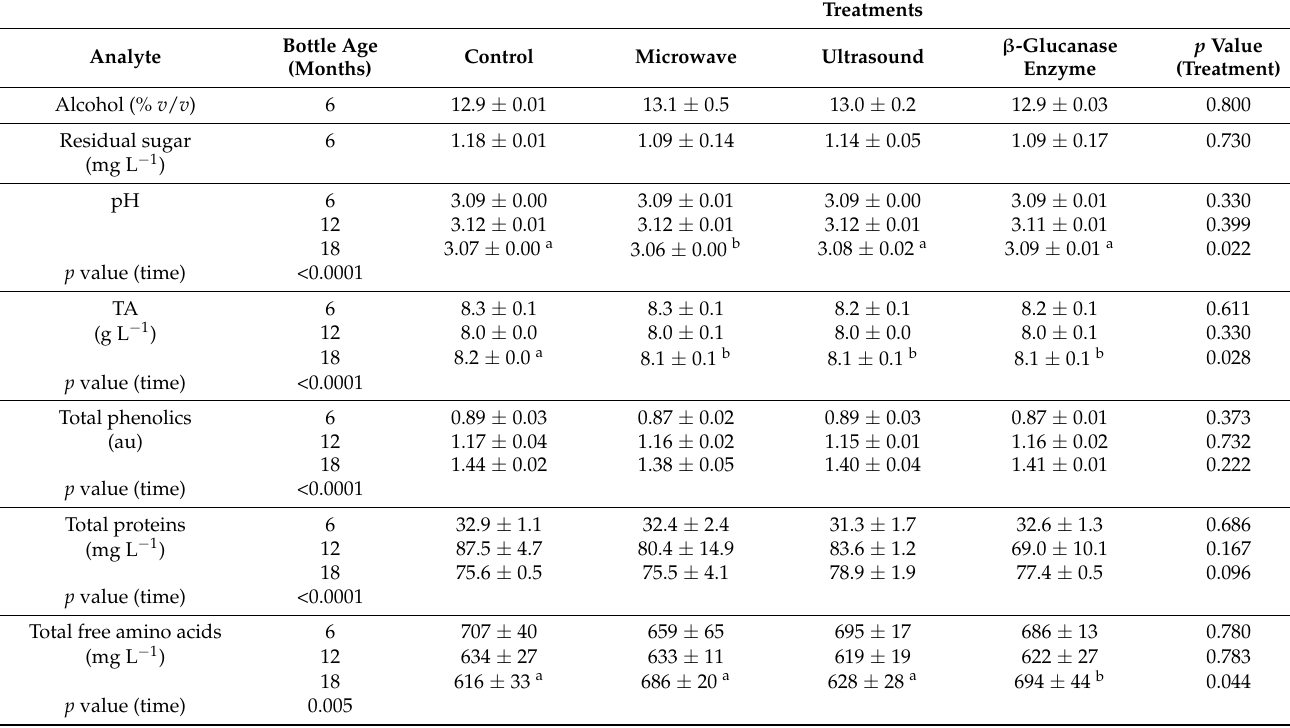
Table 1. Composition 1 of sparkling wines by treatment after 6, 12 and 18 months bottle ageing.